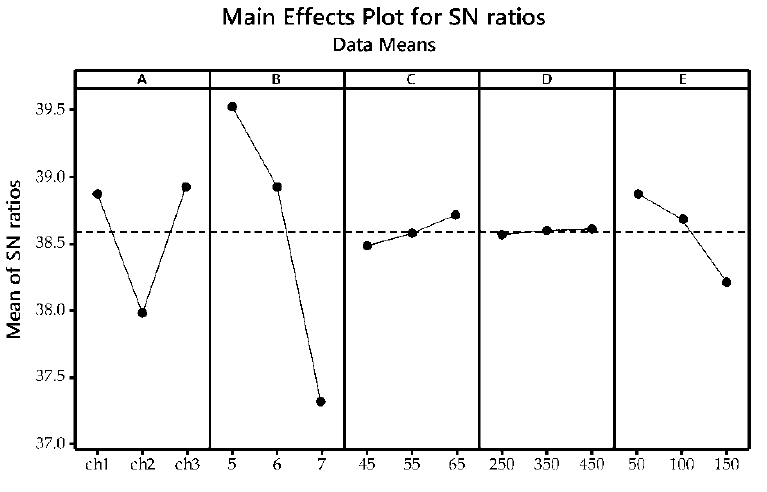
Figure 2. The main effects plot for the S/N analysis of the flocculation efficiency during the floccu- lation of the Bacillus sp. BioSol021 cultivation broth: A—chitosan type, B—pH value, C—chitosan dosage (mg/mL), D—rapid mixing speed (rpm), E—slow mixing speed (rpm).